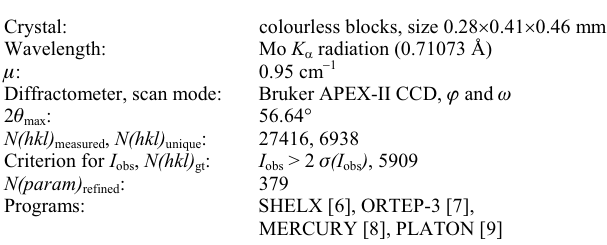
Table 1. Data collection and